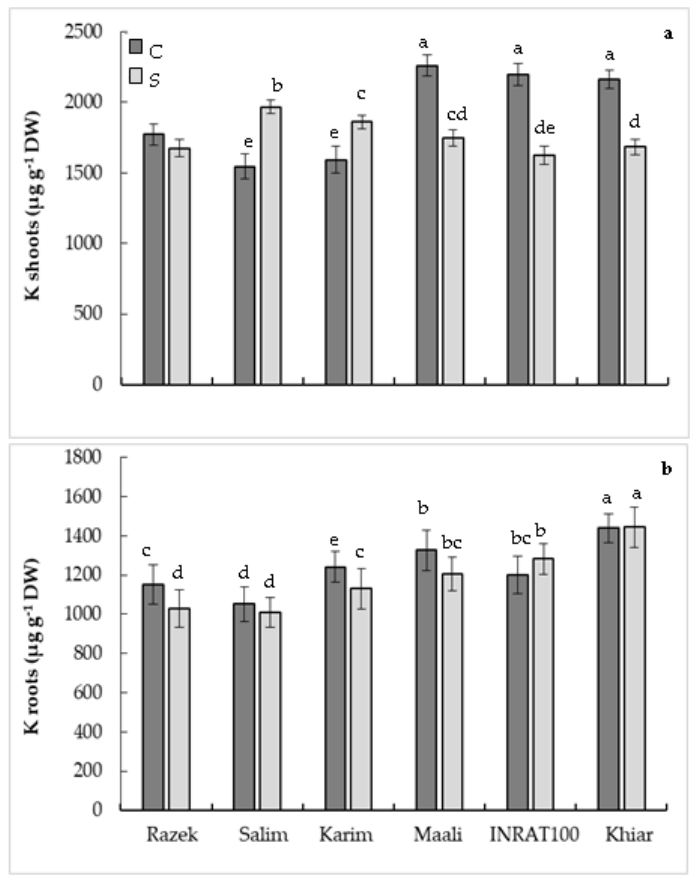
Figure 4. Potassium concentration in shoots ( a ) and roots ( b ) of durum wheat ( Triticum durum Desf.) plants subjected (S, stressed) or not (C, control) to drought stress. According to Fisher’s least significant difference, within columns, means with the same letter are not significantly different at α = 0.05. Standard errors of means of 10 replicates. Table 2. Water use efficiency for plant growth (WUE-DW), water use efficiency for photosynthesis (WUE-An), potassium use efficiency for plant growth (KUE-DW), and potassium use efficiency for photosynthesis (KUE-An) in six Tunisian genotypes of durum wheat ( Triticum durum Desf.) subjected (S, stressed) or not (C, control) to drought stress. According to Fisher’s least significant difference, within columns, means with the same letter are not significantly different at α = 0.05. Standard errors of means of 10 replicates.